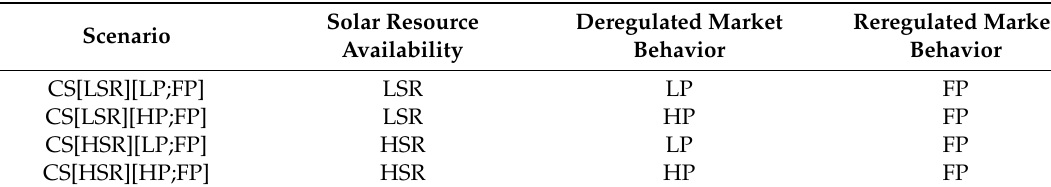
Table 4. Defined case studies for deregulated and regulated markets sale of electricity. Note: FP, Fix-Price; LP, Low Price; HP, High Price; HSR, High Solar Resource; LSR, Low Solar Resource.